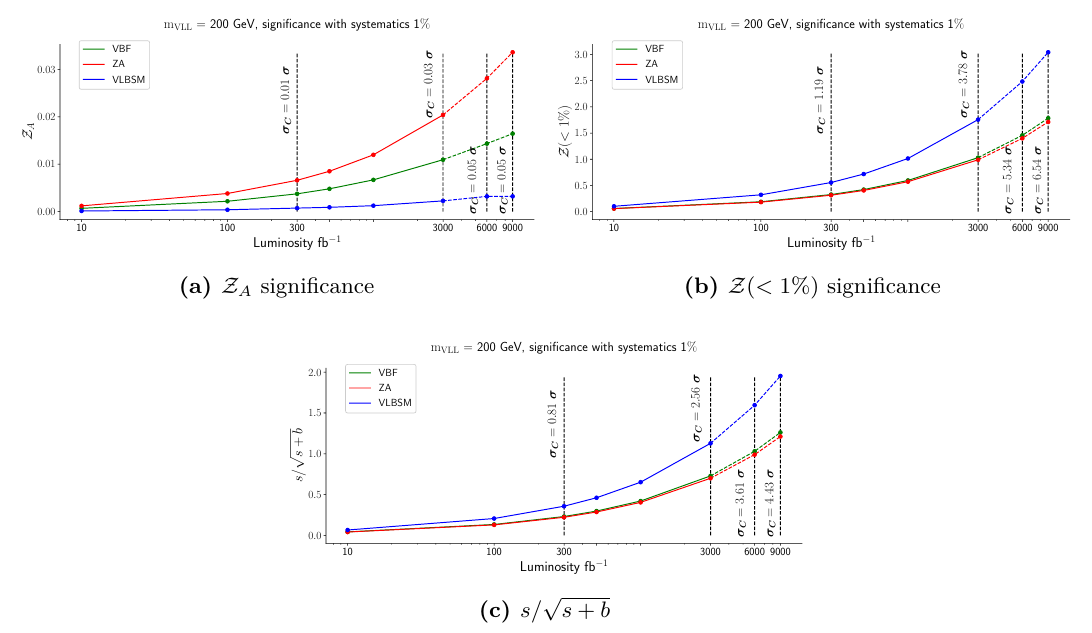
1 for the three Figure 8. Statistical significance as a function of the integrated luminosity in fb − different statistics adopted in the current analysis and for a fixed VLL mass, m E = 200 GeV. The x 2 axis is on logarithmic scale. In (a) we showcase the Asimov significance, in (b) — the adapted Asimov √ s + b metric. The colours represent the distinct signal processes significance, and in (c) — the s/ under consideration. In particular, the green curve is representative of VBF events, the red curve indicates ZA topologies, while the blue curve refers to VLBSM single production events. The dashed curves indicate that the considered values of the luminosity are beyond the LHC operation